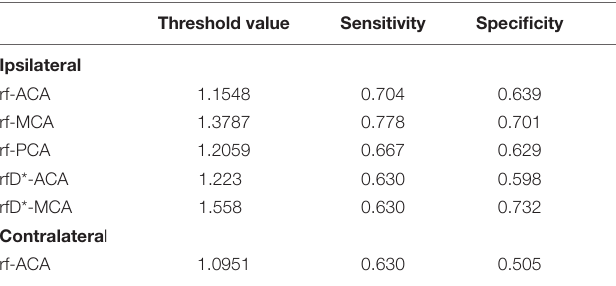
TABLE 5 | Sensitivity and specificity of diagnostic thresholds for different diagnostic indicators.